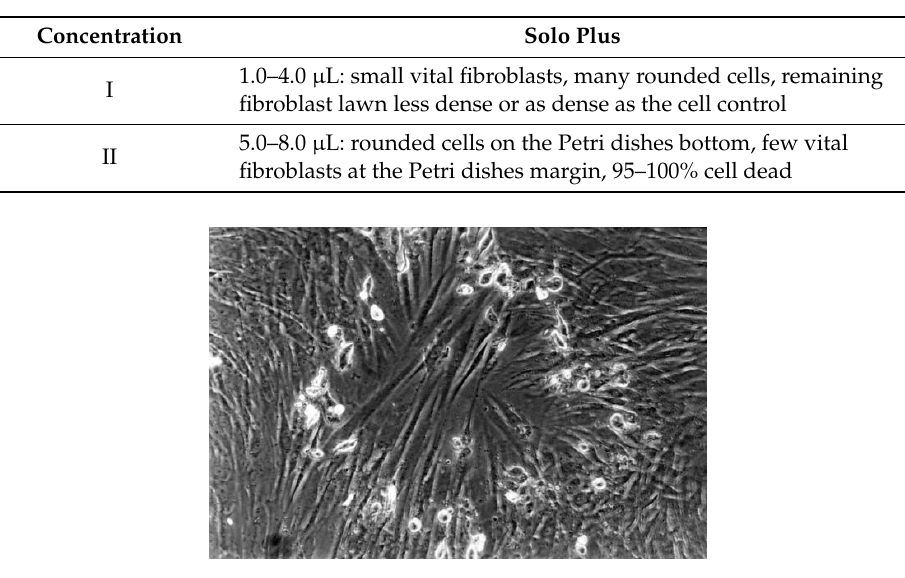
Table 9. Qualitative evaluation: Optibond Solo Plus (No. 6).